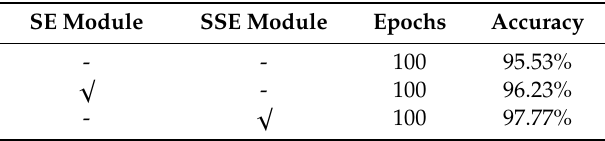
Table 2. Comparison with or without the SSE module.